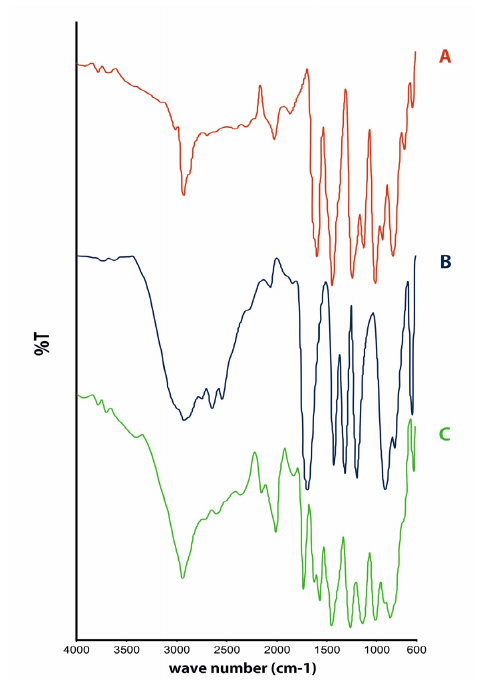
Figure 3. Fourier transform-infrared spectra of (A) piperine, (B) succinic acid, and (C) the cocrystal of piperine–succinic acid (2:1 molar ratio). Table 1. Crystal data for the piperine–succinic acid cocrystal.